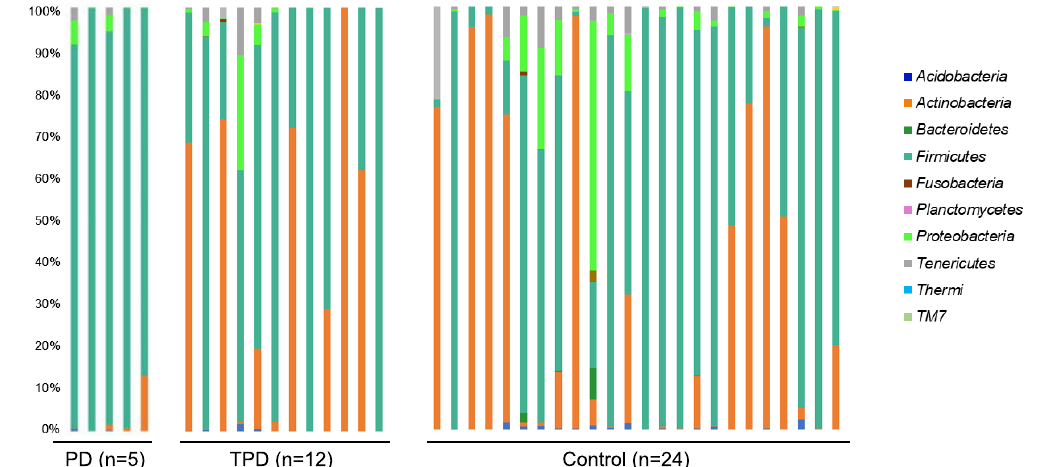
Figure 2 Relative abundance of different bacterial phyla in each sample. The seven most abundant bacterial phyla are indicated. One-way analysis of variance was performed for comparison between each group. Firmicutes: controls vs TPD, P =0.84; TPD vs PD, P =0.005; controls vs PD, P =0.0001. Actinobacteria: controls vs TPD, P =0.87; TPD vs PD, P =0.01; controls vs PD, P =0.001. Proteobacteria: controls vs TPD, P =0.61; TPD vs PD, P =0.65; controls vs PD,